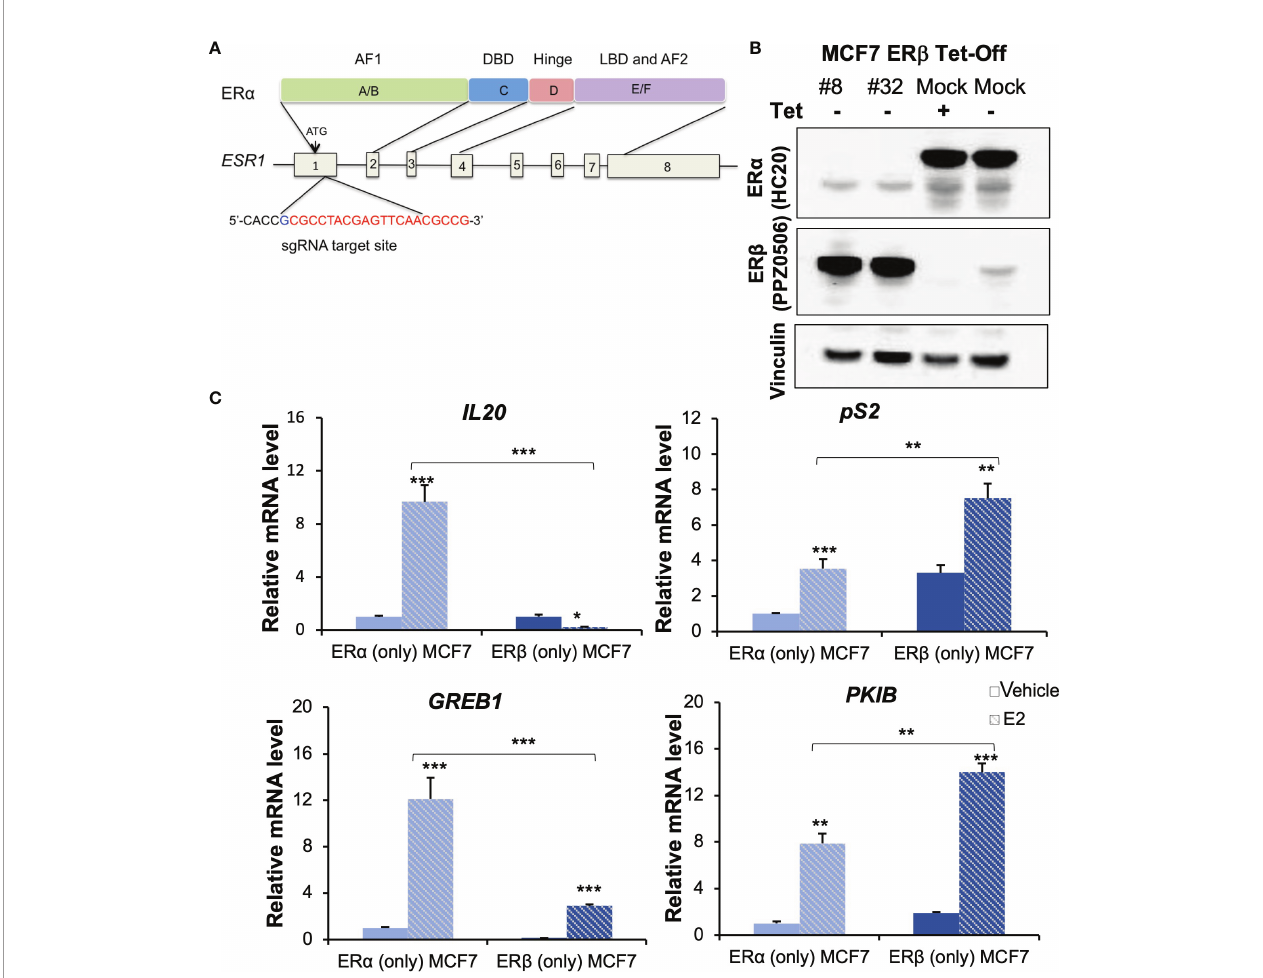
FIGURE 1 | Generation and characterization of ER b (only) MCF-7 cells. (A) Domain structure of ER a (upper) and genomic structure of ESR1 gene (bottom). The sgRNA target site is located at 5 ’ -end of exon 1 and the 20-nt guide sequence is indicated in red letters. (B) ER expression was validated for the indicated receptors by Western blot analysis, using vinculin as loading control. Lane 1-2: ER b (only) #8 and #32 clones, lane 3: ER a (only) cells (mock, in presence of Tet) and lane 4: showing induction of ER b (mock, 20h after removal of Tet). (C) mRNA levels of IL20 , pS2, GREB1 and PKIB were measured by qPCR in ER a (only) and ER b (only, #32) following treatment with vehicle or E2. Data is represented as means + SD (n=3) and analyzed using two-way ANOVA followed by Bonferroni test, * P < 0.05, ** P < 0.01, *** P <